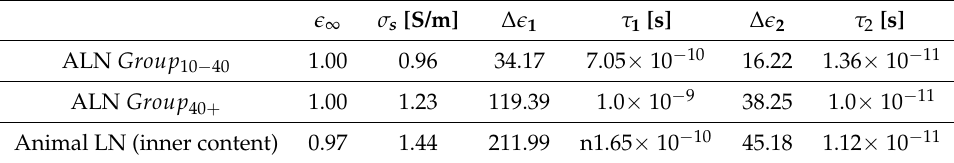
Table 2. Two-pole Debye parameters fitted to the mean permittivity computed on three different groups of data. The first two rows refer to human axillary lymph node data, divided into two different groups, according to their relative permittivity values. The third row refers to all the data acquired when measuring the inner content of sheep lymph